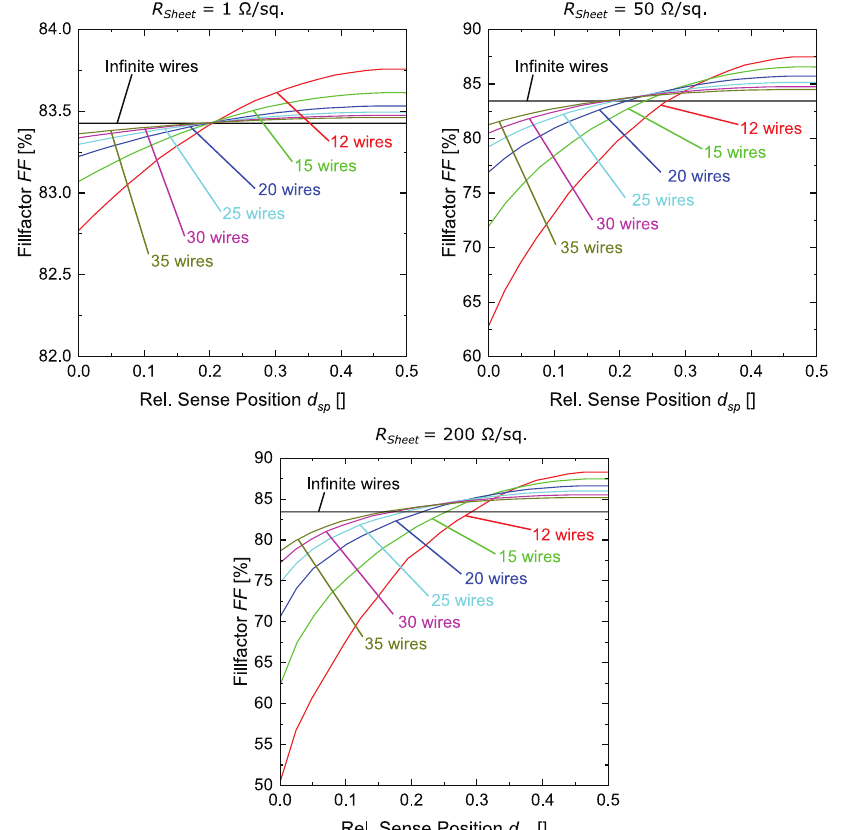
Fig. 5. Fill factor between two current wires at MPP conditions for a HJT solar cell with R Sheet = 1 V /sq, 50 V /sq and 200 V